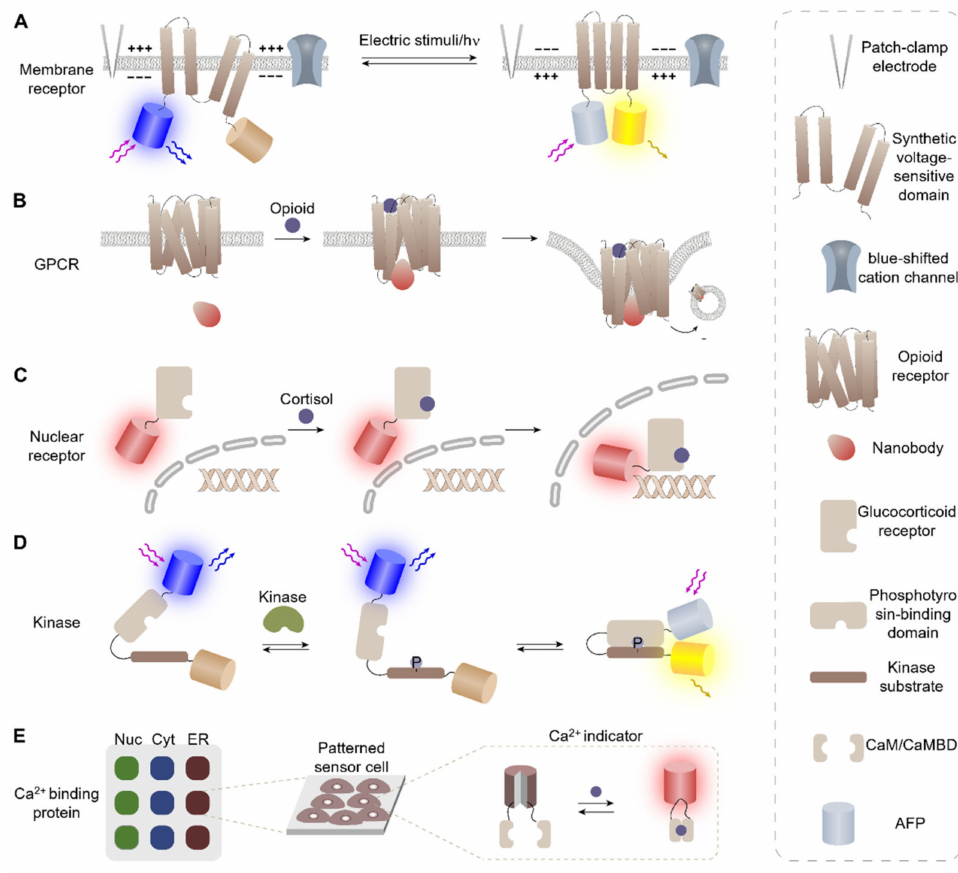
Figure 1. Cell-based sensors developed using various recognition elements. ( A ) The chimeric voltage- sensitive domain is used for detecting membrane potential induced by a patch-clamp electrode or light-gated ion channel. ( B ) Fluorescence protein-tagged nanobodies are used to detect conforma- tional changes in OR and their intracellular trafficking. ( C ) Nuclear receptor GR was used to screen for agonists and antagonists from mixed reagents. ( D ) Kinase activity was monitored using a kinase substrate and its complemented binding domain. ( E ) Ca 2+ binding domains were used to fabricate genetically encoded Ca 2+ indicators and Ca 2+ detecting sensor cells targeting different organelles were fabricated in situ for multiplexed sensing in subcellular